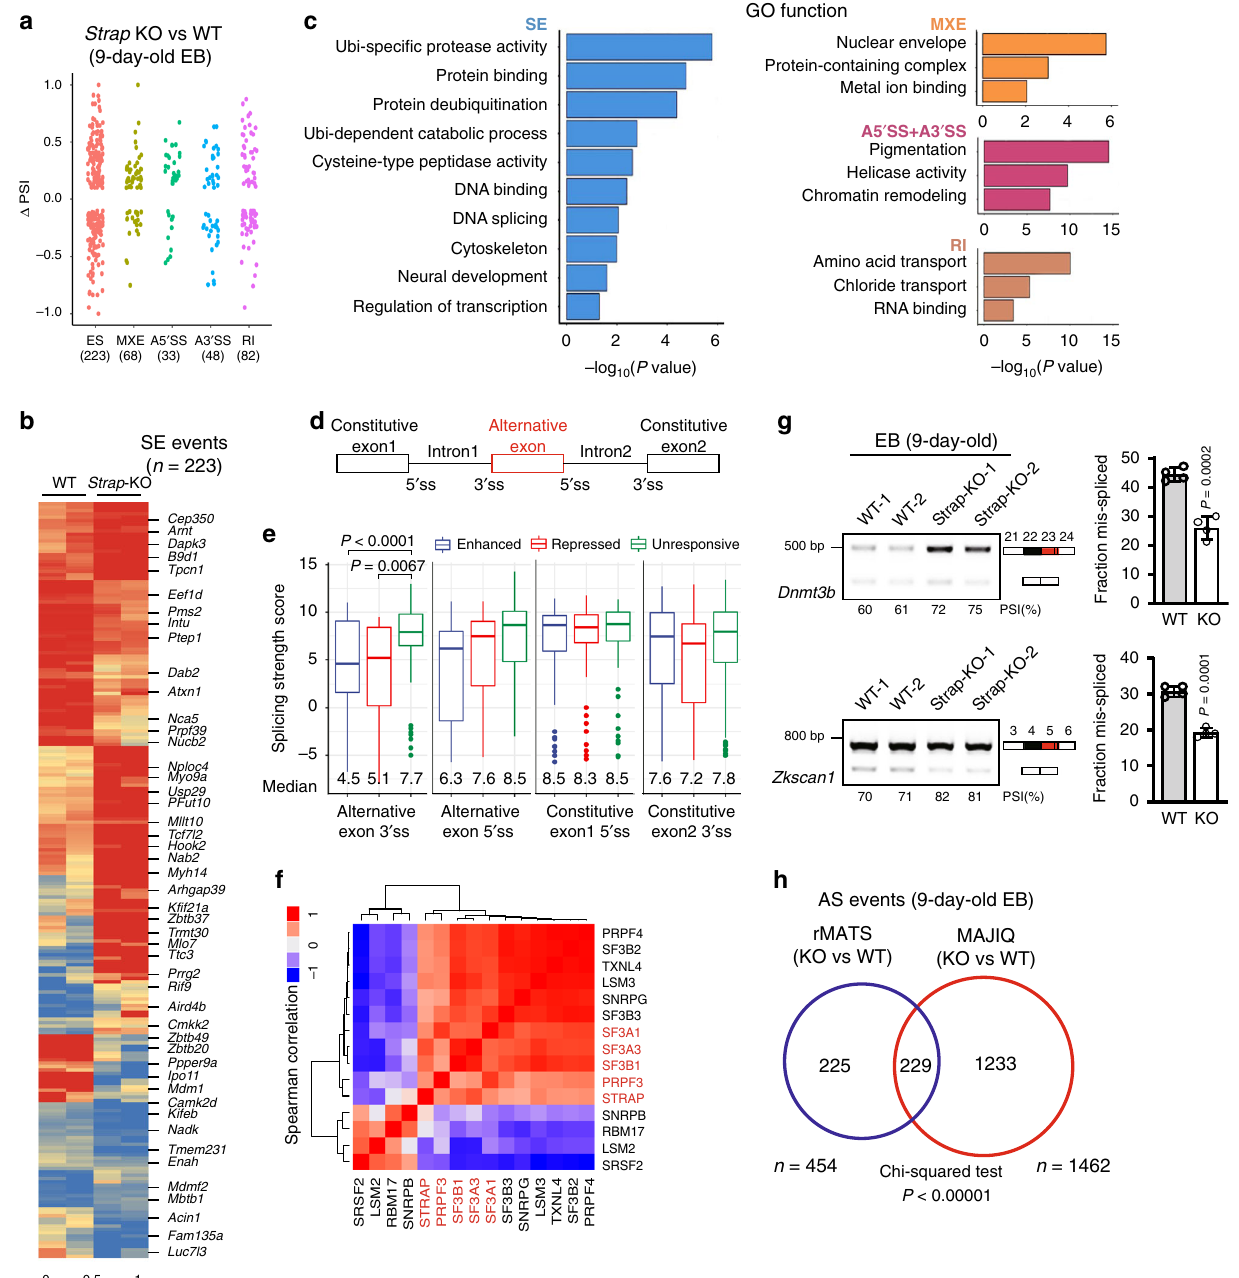
genes list derived from merged eCLIP peaks as a reference dataset, we found that 15.6% (319 of 2047) of STRAP